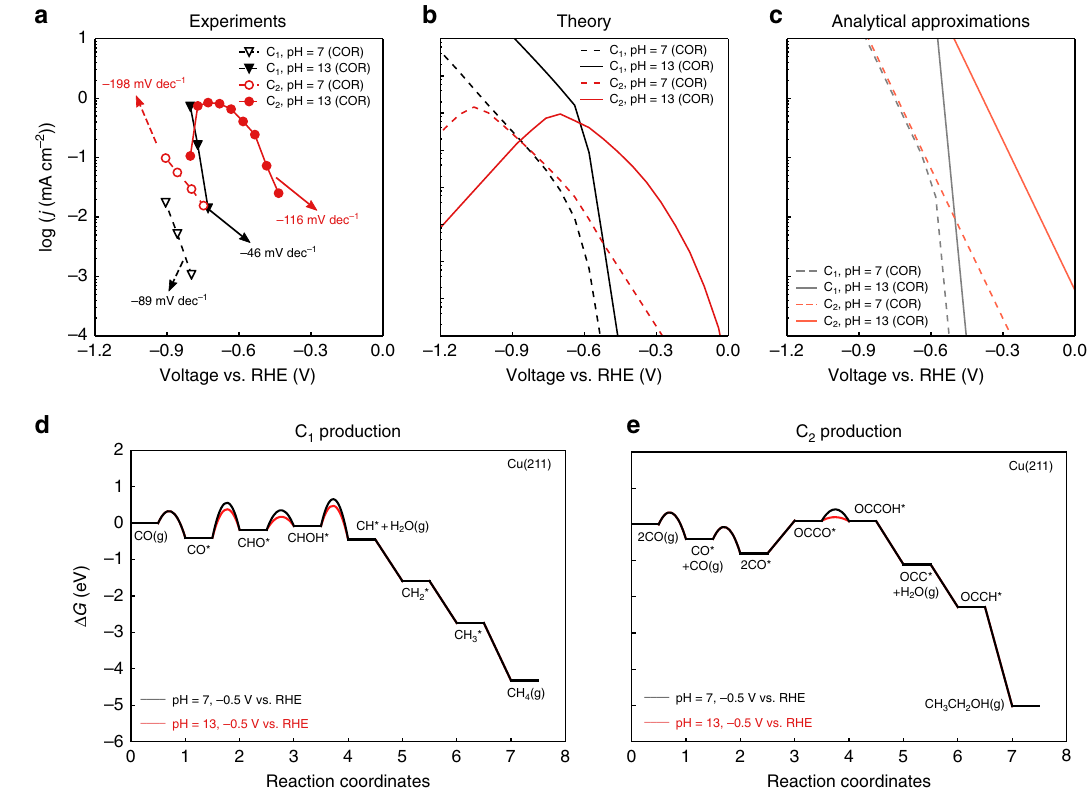
Fig. 4 The effect of pH on C 1 and C 2 product activities. a Measured COR activities toward C 1 and C 2 on pc-Cu at pH = 7 and 13. Data are taken from Wang et al. 26 . b Predicted COR polarization curves from the microkinetic model at pH = 7 and pH = 13. c Approximated COR polarization curves using Eq. 4 at pH = 7 and pH = 13. d Free energy diagram of the dominant pathway at low coverage for C 1 formation at – 0.5 V vs. RHE at pH = 7 and pH = 13. e Free energy diagram of the dominant pathway at low coverage for C 2 formation at – 0.5 V vs. RHE at pH = 7 and pH =